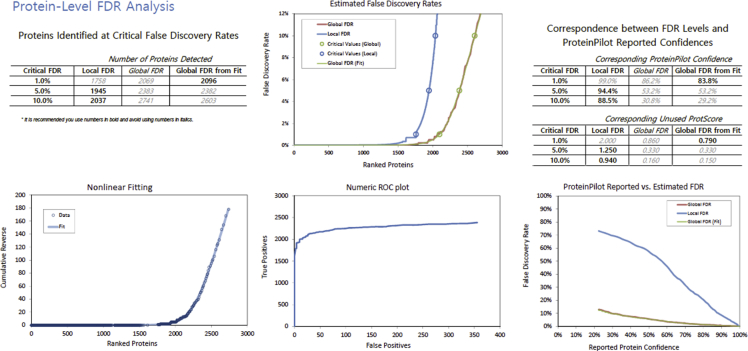
FDR analysis report of comprehensive IDA library from chicken corneas at protein level generated by ProteinPilot software.